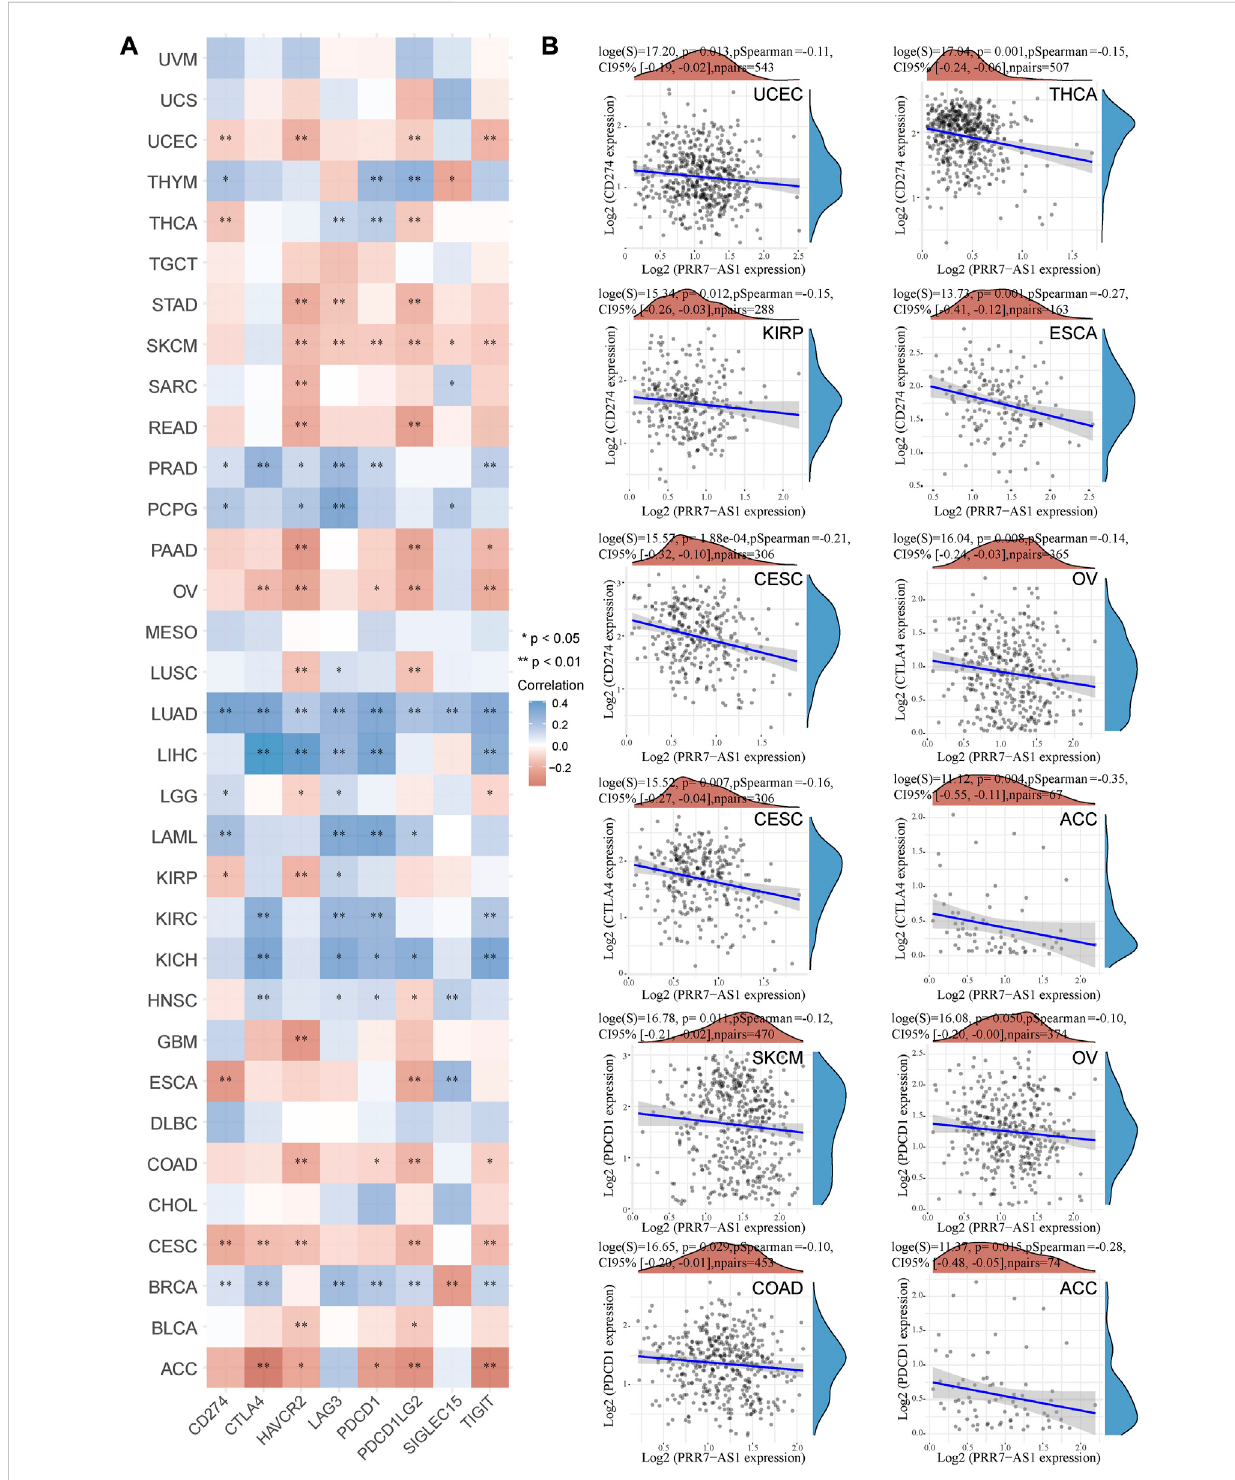
Correlation between PRR7-AS1 and immune checkpoint gene expression. (A) Heat map of PRR7-AS1 expression levels correlated with immune checkpoint genes in pan-cancer from the ACLBI database. (B) Scatter plots of PRR7-AS1 expression levels correlated with CD274, PDCD1 and CTLA4 in cancers. Correlation was tested by Spearman methods. * p < 0.05, ** p <